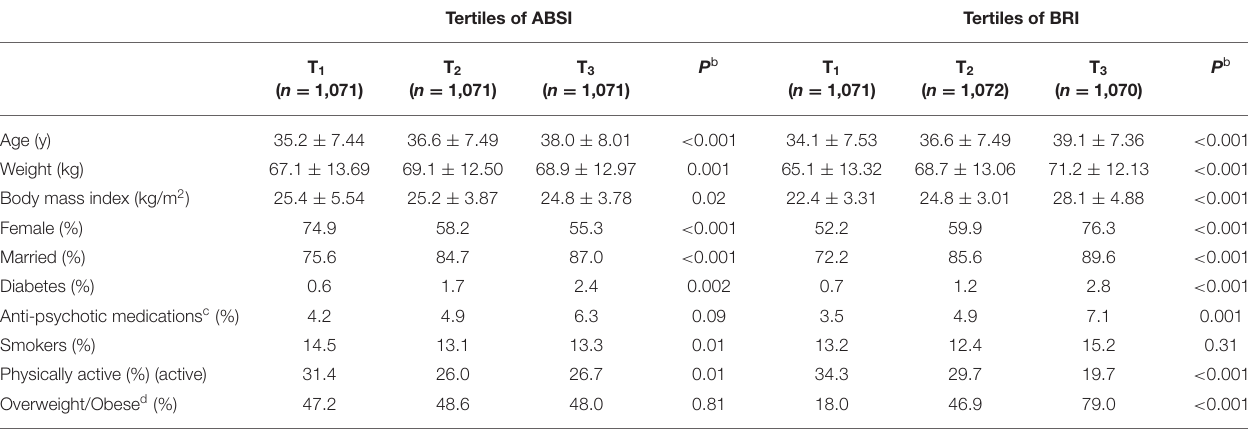
TABLE 1 | General characteristics of study participants across tertiles of ABSI and BRI ( n = 3,213) a . Tertiles of ABSI Tertiles of